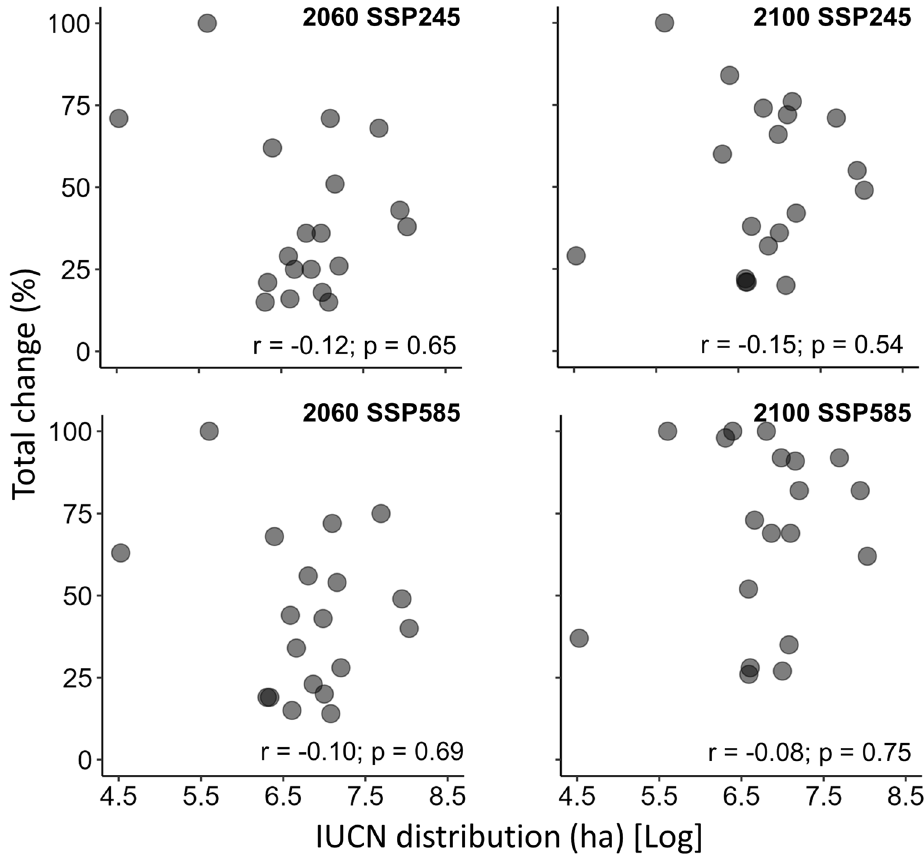
Figure 2. Scatterplots between the species’ IUCN geographical range and the relative total change expected in the climatic suitability area for Atlantic Forest endemic primate species (n = 19) in two Shared Socioeconomic Pathways (SSP2-4.5 and SSP5-8.5, the most pessimist one) for two times in the future (2060 and 2100) without considering potential dispersal. Total change is the sum of predicted area gain and area loss and is proportional to the current climatic suitability distribution area. Pearson correlation test results ( Pearson r and p values) are show inside the graphs. We also run non-parametric Spearman correlation tests, with the same qualitative results (no correlation).